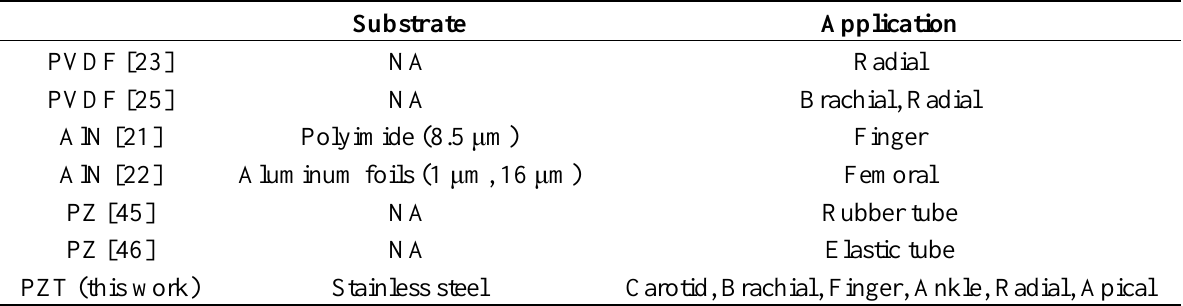
Table 2. Comparison of piezo-electric tactile sensors with different flexible substrates.